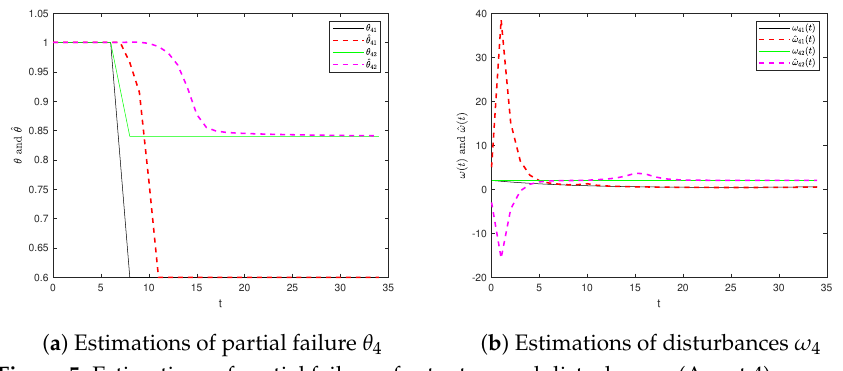
Figure 5. Estimations of partial failure of actuators and disturbances (Agent